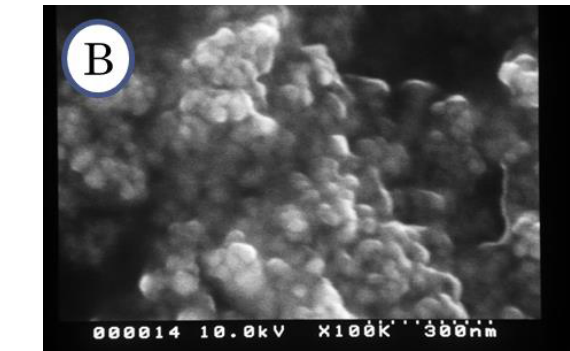
Figure 8. XRD patterns of the TiO 2 and Rh/TiO 2 photocatalysts.